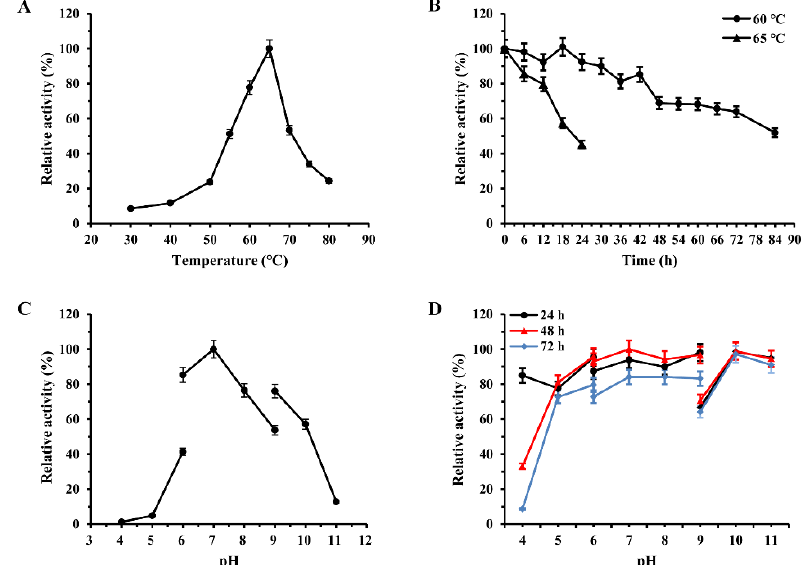
Figure 3. Effect of temperature and pH on the activity and stability of recombinant GSJ. ( A ) Optimum temperature. Activity was measured between 30 ◦ C and 90 ◦ C at pH 7.0 for 10 min. The activity at optimum temperature was defined as 100%. ( B ) Thermostability. Assays were carried out in 50 mM phosphate buffer (pH 7.0) at 65 ◦ C for 10 min after the incubation of the enzyme at 60 ◦ C ( • ) or 65 ◦ C ( (cid:78) ). The activity without heat treatment was defined as 100%. ( C ) Optimum pH. Assays were carried out at 65 ◦ C for 10 min in buffers ranging in pH from 4.0 to 11.0. The activity at optimum pH was defined as 100%. ( D ) pH stability. Assays were carried out after the incubation of the enzyme in buffers ranging from pH 4.0–11.0 at 4 ◦ C for 24–72